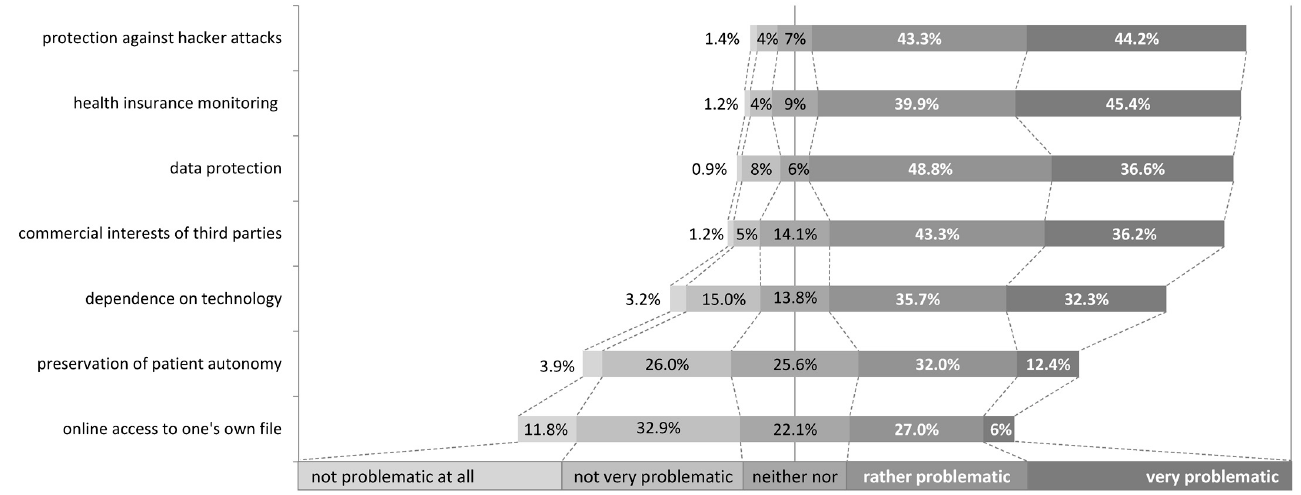
Figure 3. Presentation of the assessment of the medical students ( n = 434) on the question “How problematic do you think the following points are with regard to digitalization in medicine?” on a 5-point Likert Scale.